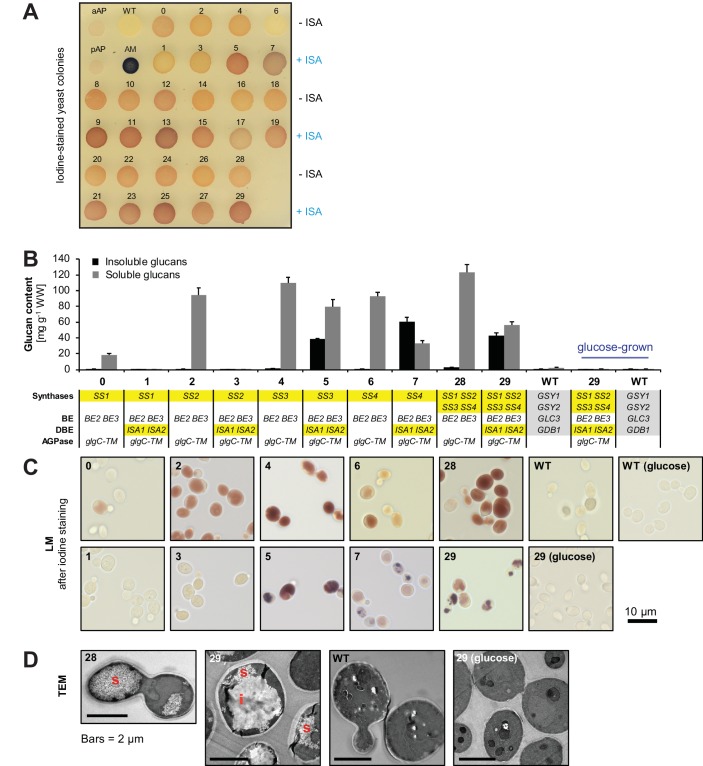
Yeast strains synthesize high amounts of glucans.(A) Iodine staining of 30 yeast strains (numbered 0–29) which vary the complement of SS isoforms and ISA1/ISA2 in the glycogen-metabolism free background. Cells were grown for 24 hr on plates with galactose and then stained with iodine vapor. Wild-type (WT) yeast, potato amylose (AM) dissolved in DMSO and native, non-gelatinized plant amylopectins from Arabidopsis (aAP) and potato (pAP) are shown for comparison. Indicative genotypes are given in B and Figure 3—figure supplement 1. Full genotypes are listed in Supplementary file 1A. (B) Quantification of insoluble (black bars) and methanol-precipitable soluble (grey bars) glucans of yeast lines grown for 6 hr in liquid main cultures with galactose. The genotypes are indicated; the varying SS and ISA1/ISA2 genes are highlighted in yellow and the endogenous yeast genes in grey. For the glucose-grown cultures in B-D, galactose was replaced by glucose to repress heterologous gene expression. Values are means ± S.D. from 4 replicate cultures (except for the glucose-grown samples, and line 6, where n = 3). WW, wet weight; BE, branching enzyme; DBE, debranching enzyme; AGPase, ADPglucose pyrophosphorylase. (C) Light micrographs (LM) from cells of the indicated yeast lines grown as in B. Cells were stained with iodine. (D) Transmission electron micrographs (TEM) of the indicated yeast lines (grown as in B) after chemical fixation. While only particulate, putatively soluble glucans (s) were observed in line 28, line 29 also contained uniform, putatively insoluble glucans (i).DOI:
http://dx.doi.org/10.7554/eLife.15552.00810.7554/eLife.15552.009Figure 3—source data 1.Glucan contents of individual replicates from strains 0 to 29.